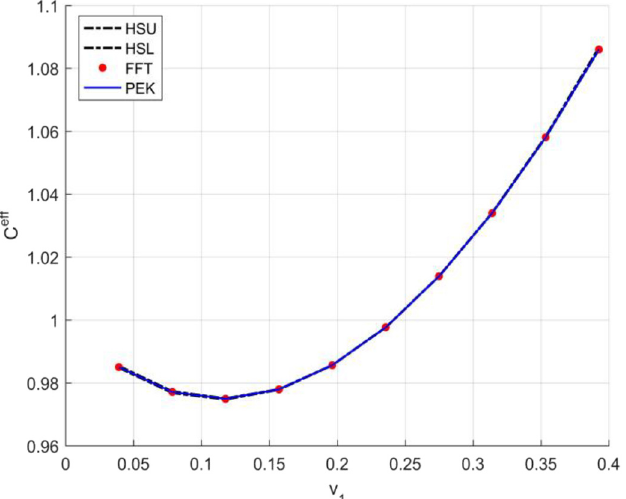
Fig. 9. Effective conductivity of square model with imperfect Fig. 7. Effective conductivity of square model with imperfect interface of ellipse Kapitza ’ s type, a =0.2, c 1 = c ¼ 100 . M Table 4. Comparison of results ( C eff ) of FFT, PEK and Monchiet ’ s results for square model with one circle inclusion in = a = R the unit cell a = 1, a 1 2